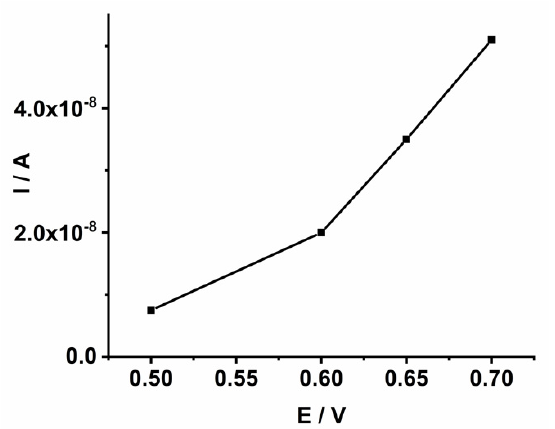
Figure 6. The influence of the working detection potential on the SNGCE/AuNP sensor’s response.